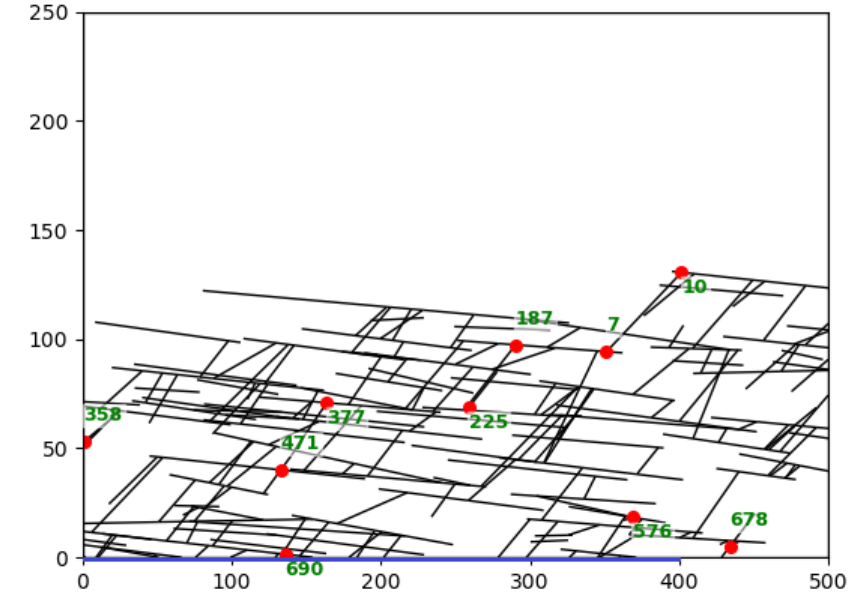
Figure 11—log-log plots of MSD vs. time for 10 sampled nodes in Case 2. Case 3.